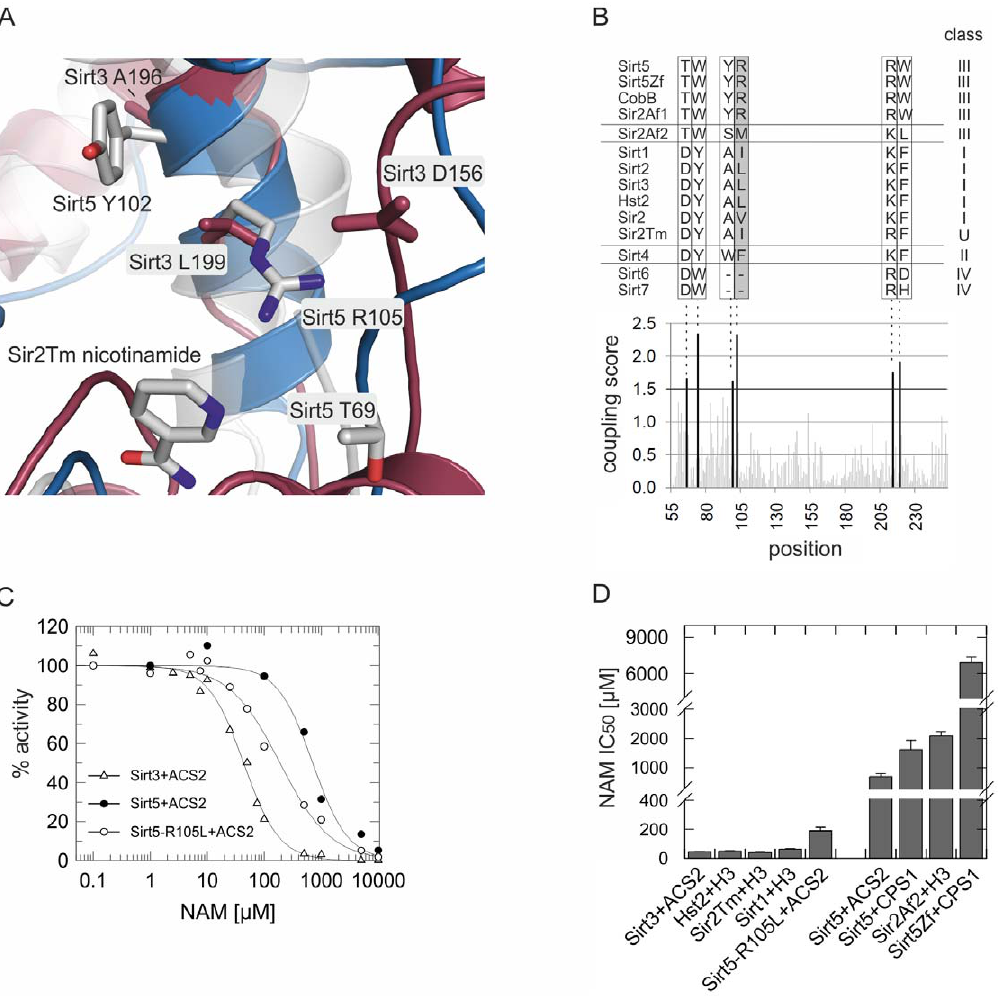
Figure 3. Structure comparison and identification of a Sirtuin sequence motive indicating nicotinamide insensitive deacetylation activity. ( A ) Structure comparison of Sirt3 (red) and Sirt5 (blue), overlaid with a Sir2Tm/nicotinamide complex (grey). Nicotinamide and coupled residues (see below) in Sirt3 and Sirt5 are displayed as sticks and colored by atom type for Sirt5 and for nicotinamide. ( B ) Statistical coupling analysis scores (lower panel) identify residues apparently coevolving (score cutoff used: 1.5) with Sirt5-Arg105: Thr69 and Tyr102 (highlighted in panel A), Trp77, Arg217, and Trp222. Amino acids in other Sirtuin sequences and the corresponding Sirtuin class are shown on top of the scores. ( C ) Inhibition Sirt5-Arg105Leu by nicotinamide. Activities, determined using our mass spectrometry assay, were normalized against activity in absence of nicotinamide. Data for wildtype Sirt3 and Sirt5 from Fig. 2A are shown here for comparison. ( D ) Comparison of IC 50 values, determined using the mass spectrometry assay, for nicotinamide inhibition of class I and III Sirtuins and of the Sirt5-Arg105Leu variant. Error bars represent the standard error of the fit. NAM, nicotinamide.